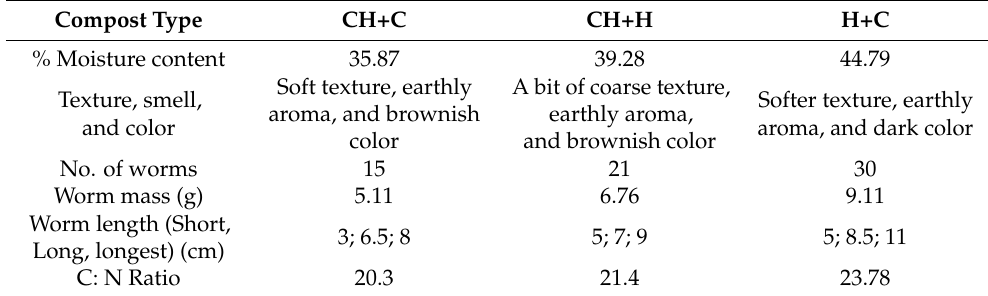
Table 2. Physical characteristics of composts for determination of compost maturity and